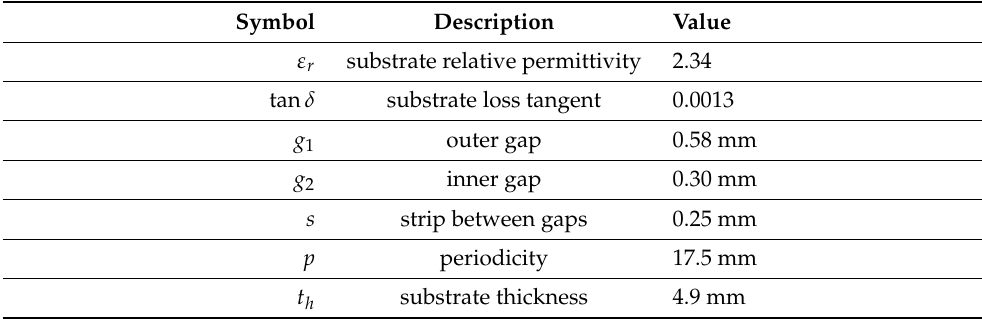
Figure 4. Reflection phase of the double-square element when a single parameter is varied: ( a ) g 1 ; ( b ) g 2 ; ( c ) t h . For better visualization, the insets show the part of the structure related to the parametric variation. Table 1. Parameters of a double-square unit